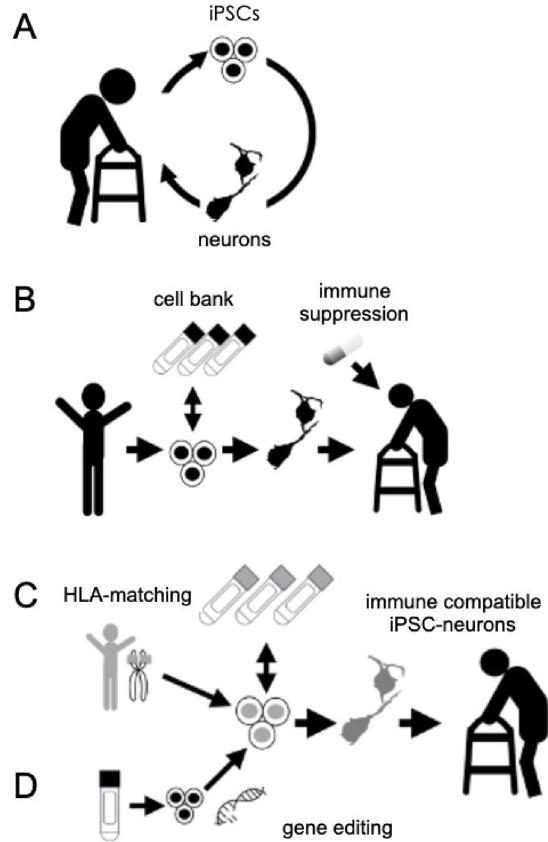
Fig. 1 Modes of stem cell therapy. A Autologous transplantation with the patient’s own induced pluripotent stem cells (iPSCs). B Allogeneic transplantation with iPSCs from healthy donors or human embryonic stem cells without HLA-haplotype matching. C Allogeneic transplantation with HLA-matching iPSCs. D Allogeneic transplantation with “universal cells” that are genetically edited to knock down HLA